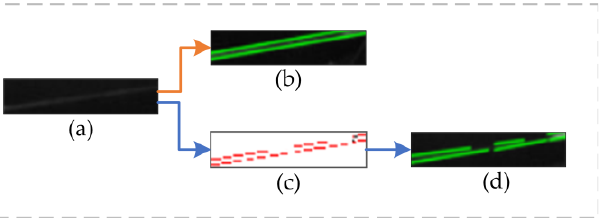
Figure 1. The line segment fracture phenomenon is caused by the reduced number of anchors. ( a ) The original image. ( b ) Theoretical output image. ( c ) Anchor map after AG3line processing. ( d ) Actual output image.